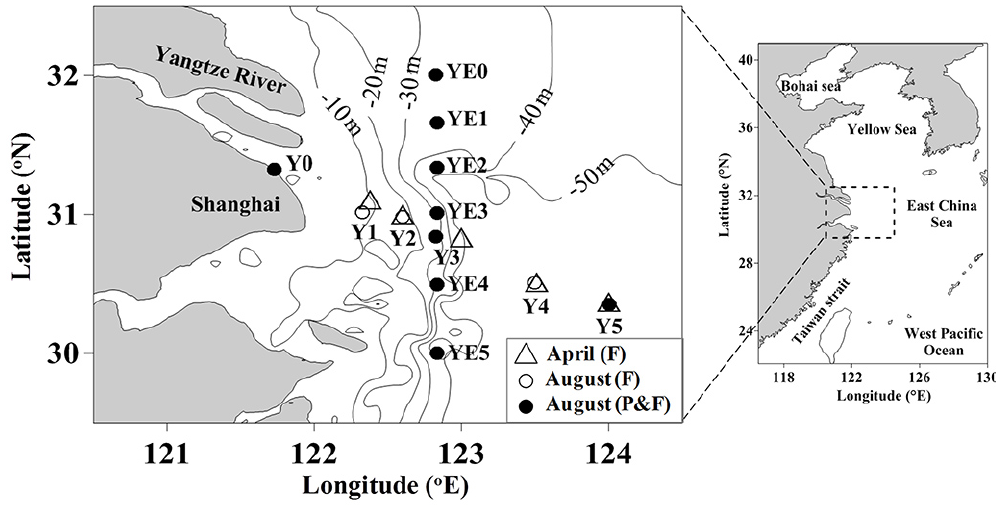
Fig. 1. Location of the study sites in the Yangtze River estuary of the East China Sea. Isobaths are used as the background. F: free-living samples; P: particle-associated